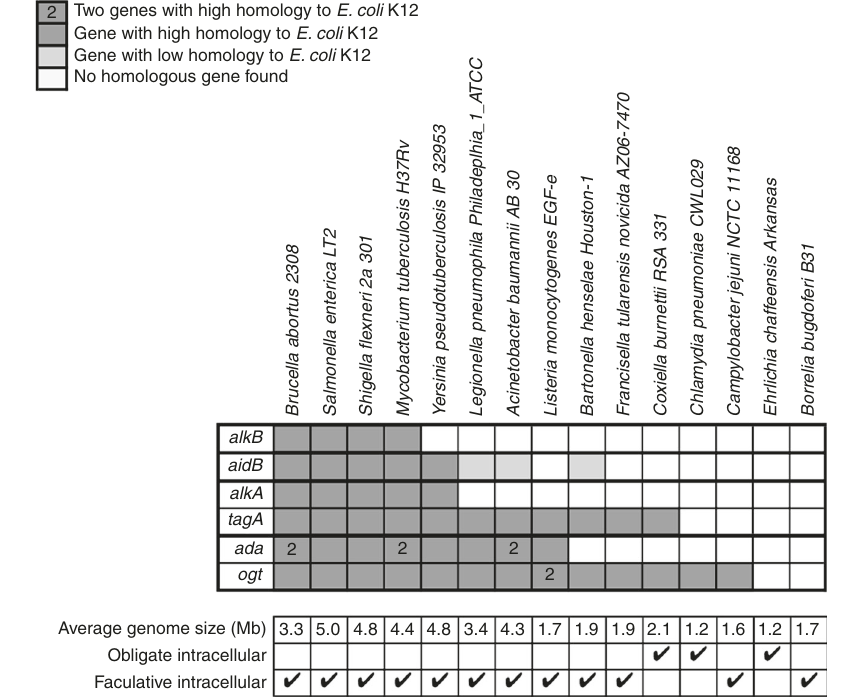
Fig. 1 Conservation of genes coding for alkylated DNA repair proteins. Genes were grouped by function. Homology was calculated based on E. coli K12 genome (www.patricbrc.org/). In the case of aidB , genes annotated as acyl-coA dehydrogenase with e -value between 10 − 29 and 10 − 44 were considered as genes with low homology and genes with e -value lower than 10 − 133 were considered as genes with high